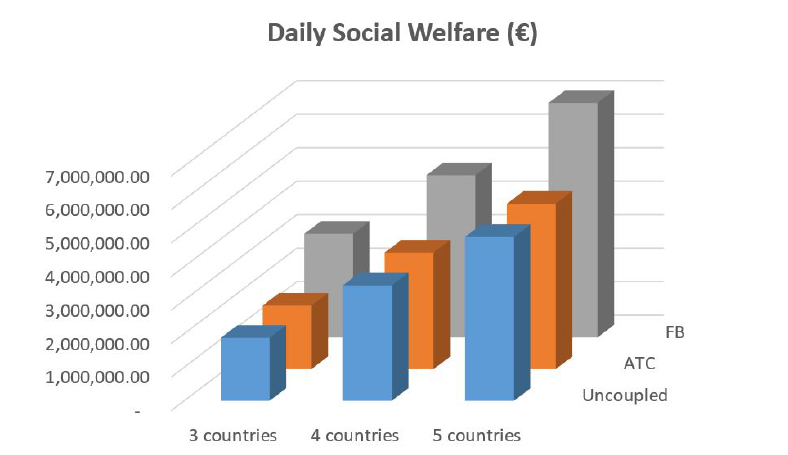
Figure 7. Total daily social welfare for different number of countries and cross-border trading